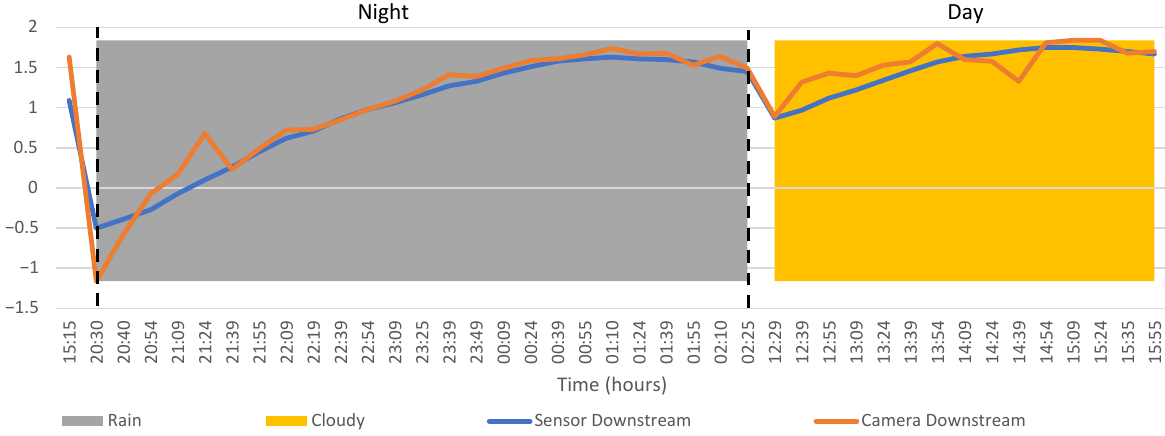
Figure 9. Water level with reference to MSL; scenario 1 displays consistent weather during each period.